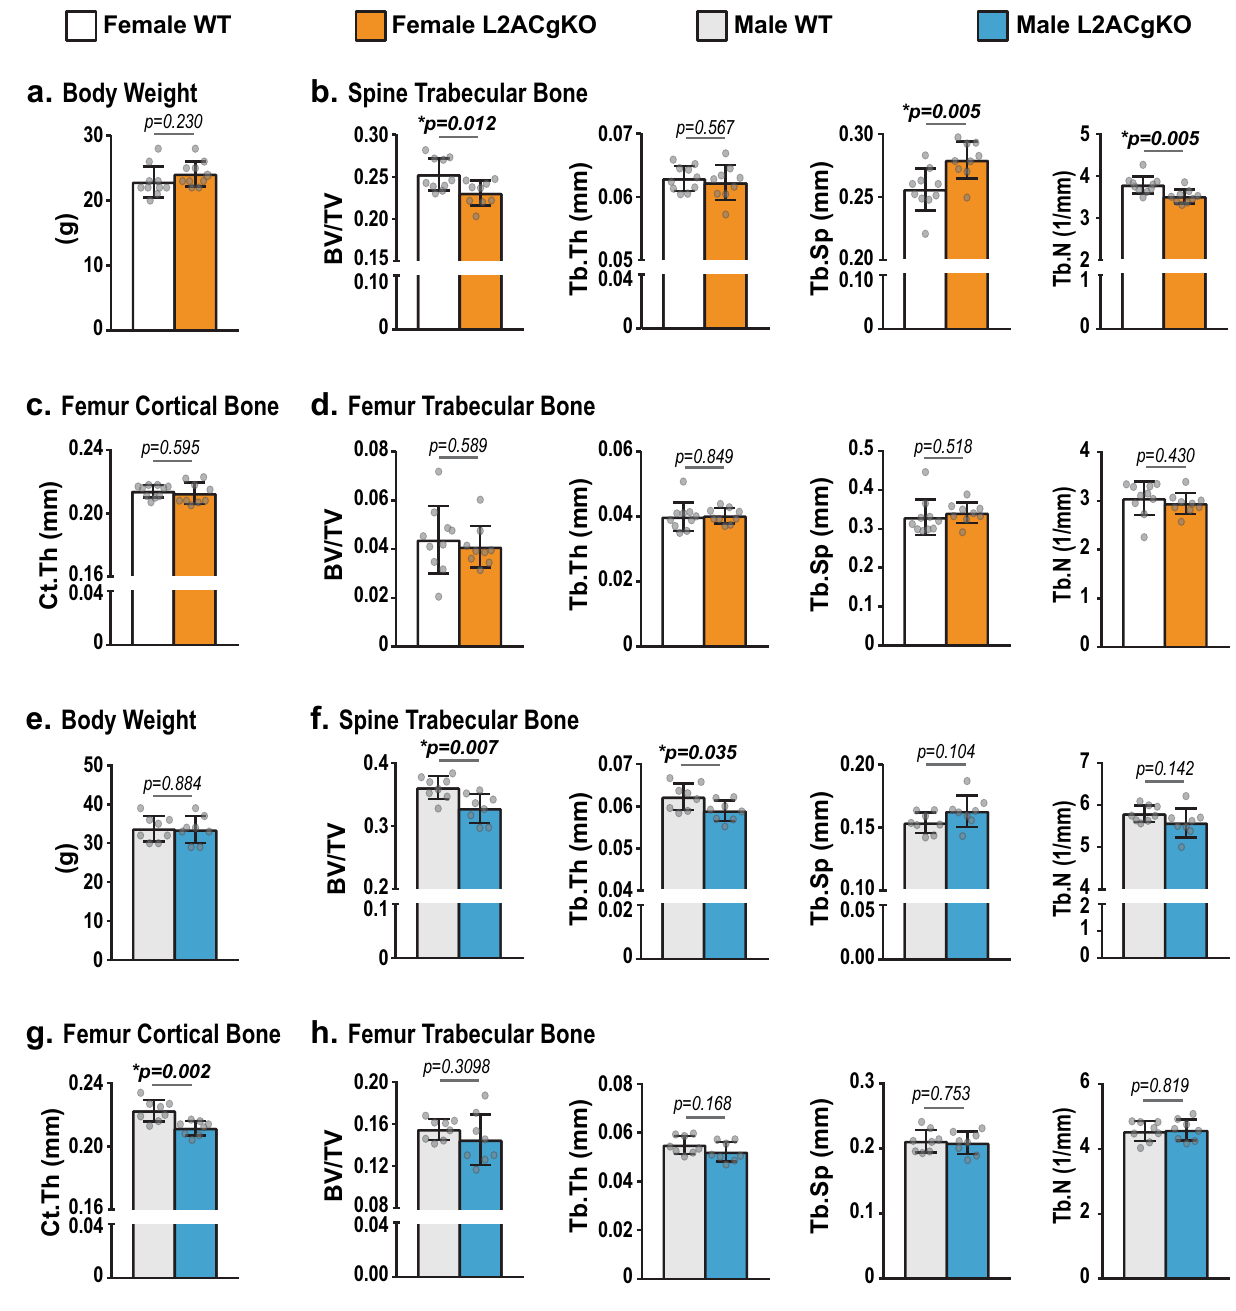
Figure 4. Skeletal analysis of young adult L2ACgKO mice. (a–h) Body weight measurements ( a,e ) and μCt analysis was performed on lumbar vertebrae 4 (L4) and femurs of 18-week-old female ( a–d ) and male ( e–h ) Lamp2AC global knock-out (L2ACgKO) mice and their wild-type (WT) littermates. ( b,f ) Cancellous bone mass and architecture were analyzed as bone volume over tissue volume (BV/TV), trabecular thickness (Tb.Th), trabecular spacing (Tb.Sp), trabecular number (Tb.N) in lumbar vertebrae 4. ( d,h) Femoral cancellous bone mass and architecture were analyzed in the distal femur. ( c,g ) Femoral cortical thickness (Ct.Th) was measured at the midshaft. n = 8–10 mice/group. Bars indicate mean ± STDEV. p values were calculated and evaluated by Welch’s t -test; *, p <